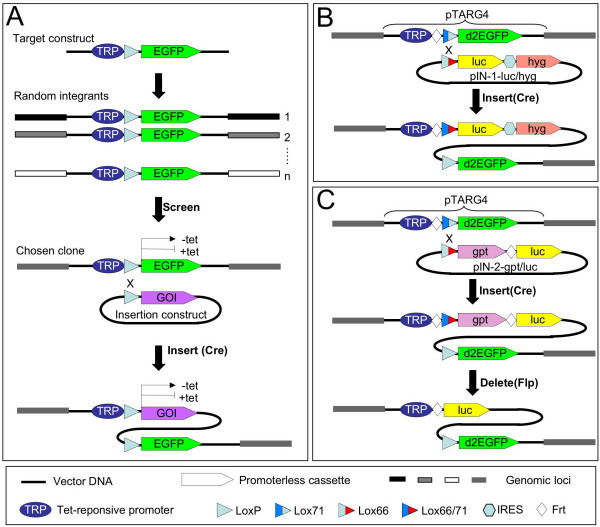
Screen and Insert principles and strategies. Configurations of plasmid DNA before and after its incorporation into genomic DNA are shown schematically (not to scale). A) Principles of the Screen and Insert approach. B) The Screen and Insert type 1 (ScIn-1) strategy. C) The Screen and Insert type 2 (ScIn-2) strategy. Promoterless cassettes are shown for a generic gene of interest (GOI), and for genes encoding green fluorescent proteins (EGFP and d2EGFP), luciferase (luc), hygromycin phophotransferase (hygro) and guanosine phospribosyltranferase (gpt). See text for details.